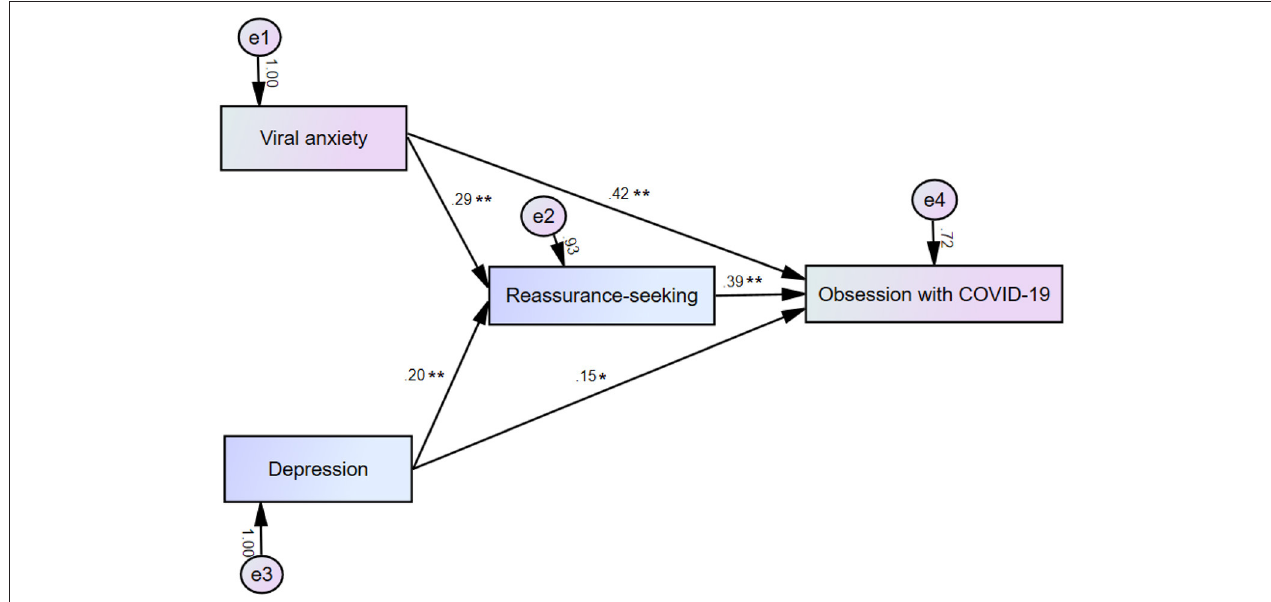
FIGURE 1 | Mediation model showing that the effect of viral anxiety or depression (independent variables) on obsession with coronavirus (outcome) is mediated by reassurance-seeking behavior (mediator). * p < 0.05, ** p < 0.01.